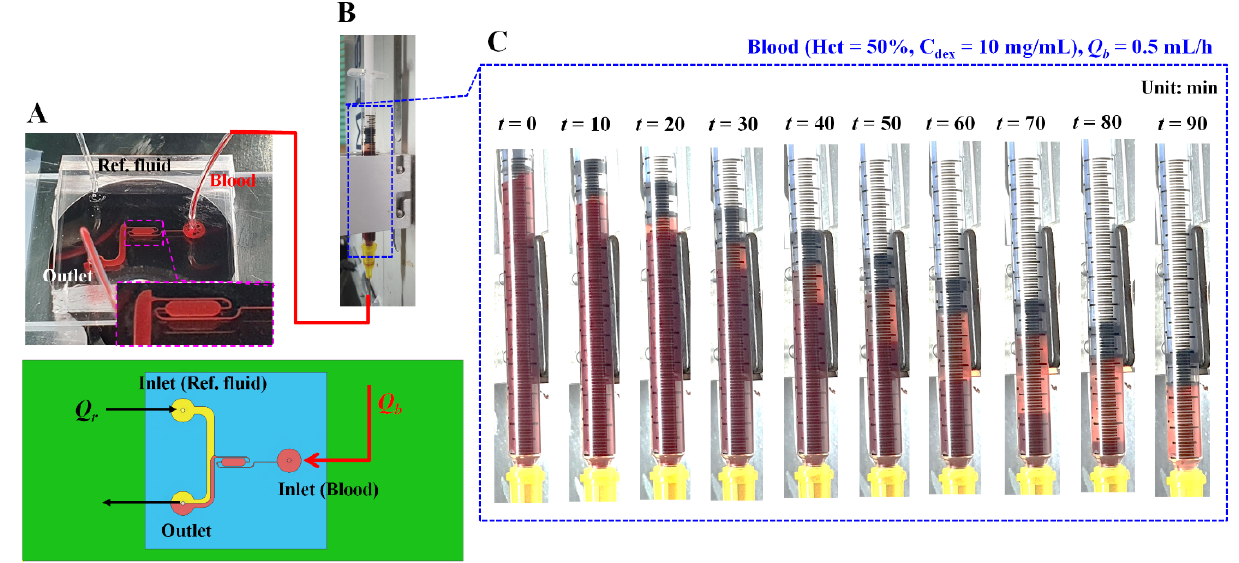
Figure 1. Microfluidic platform for quantifying red blood cell (RBC) sedimentation in terms of previous suggested factors. ( A ) Schematics of a microfluidic device (i.e., prototype, and 3D model). Microfluidic device with two inlets, outlet, two guiding channels (reference fluid channel and blood channel), and coflowing channel. Lower-side panel shows blood channel filled with blood. ( B ) Syringe pump for delivering blood as well as reference fluid. Q r and Q b denote flow rates of reference fluid and blood sample, respectively. ( C ) Snapshots for showing RBC sedimentation in the blood syringe for 90 min. In this case, blood (Hct = 50%) was prepared by mixing normal RBCs into dextran solution (10 mg/mL). Flow rate of syringe pump set to Q b = 0.5